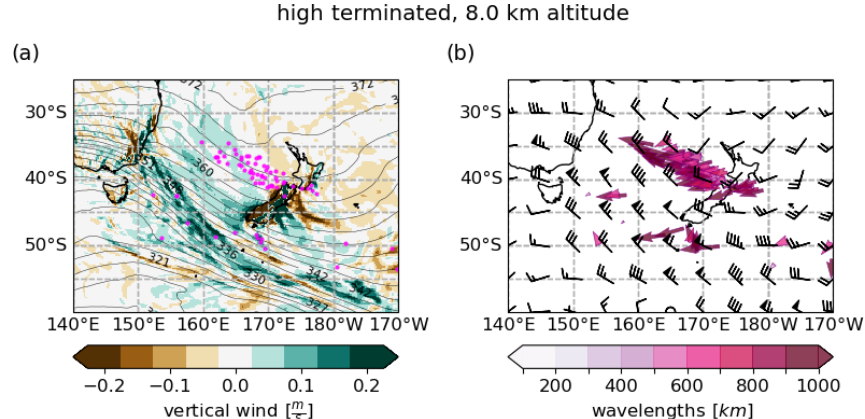
Figure 12. (a) Position of ray termination points overlain on vertical wind velocities for 31 July 2014 at 18:00UTC, i.e. 18h before the wave patterns were analysed at 25km altitude. Only ray locations that coincide with altitude and time are shown. (b) Arrows show the direction of the wave vector at the ray location. The colour code highlights the different horizontal wavelengths of the shown rays.